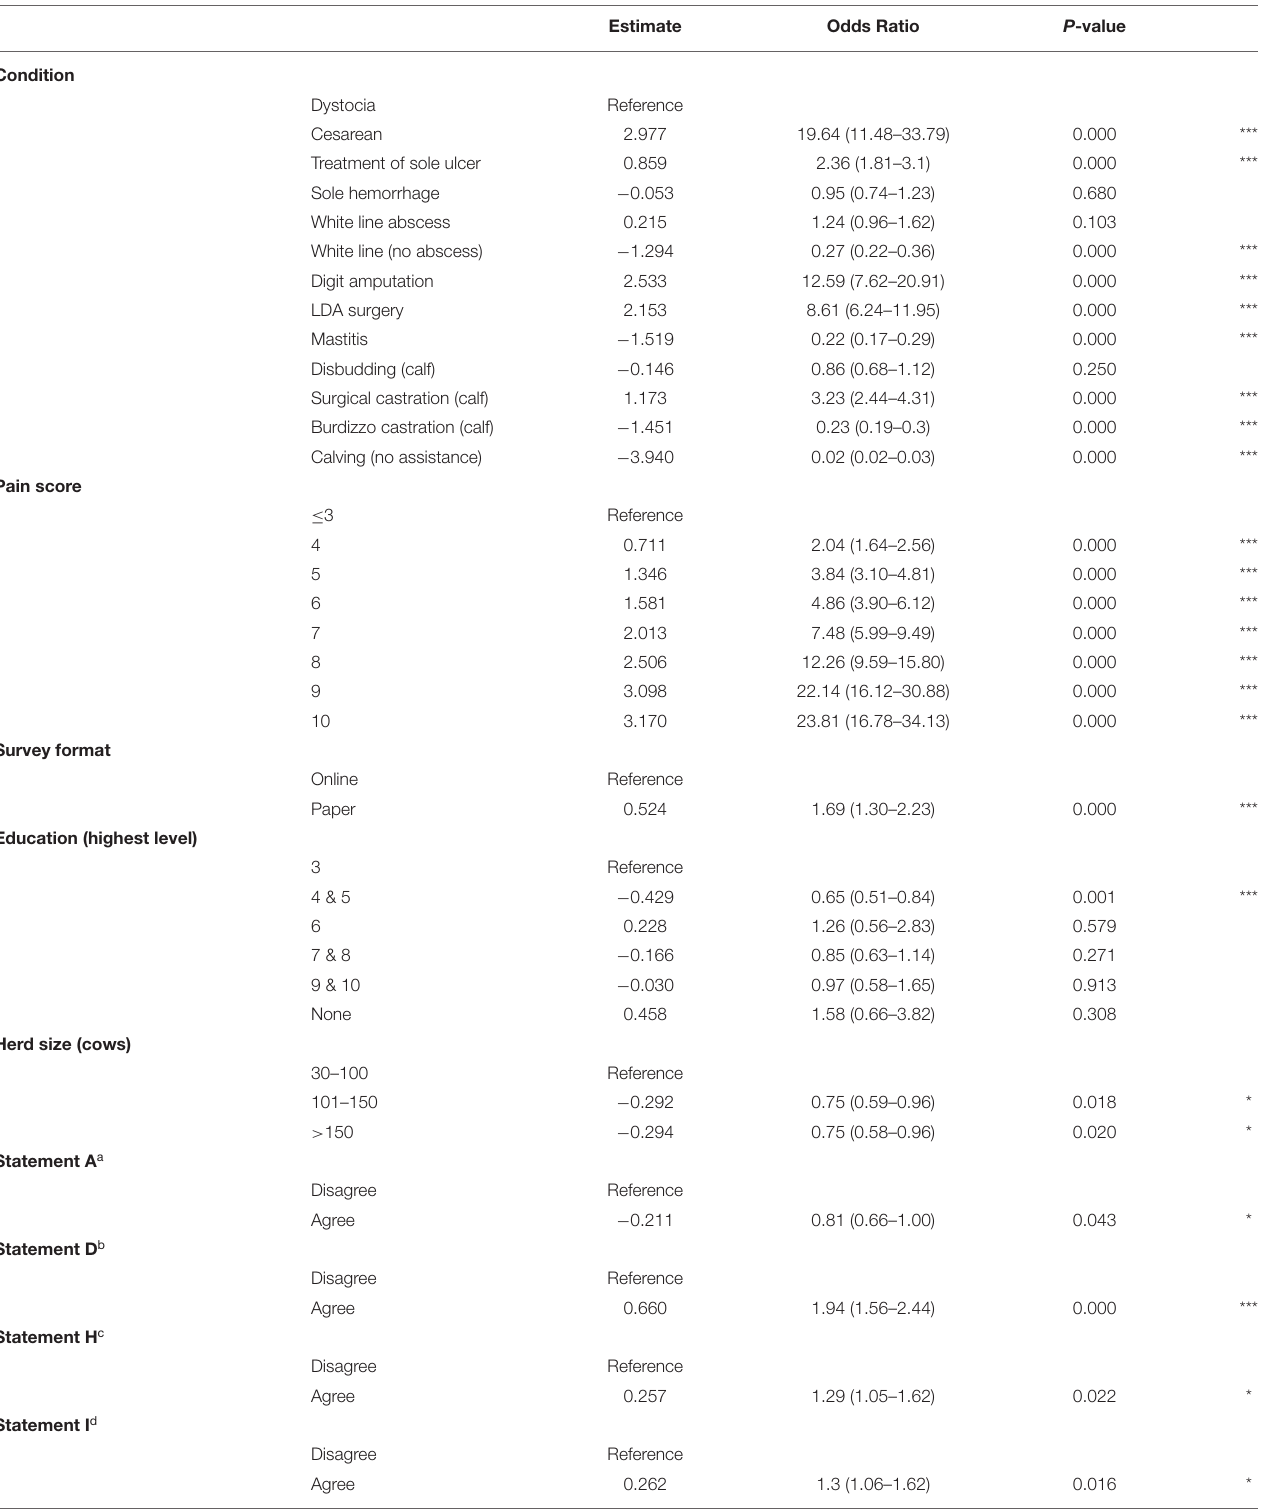
TABLE 5 | Mixed effects logistic regression model to determine factors associated with the use of NSAIDs in dairy cows by farmers, in a survey investigating attitudes to pain and analgesic use in pasture-based dairy